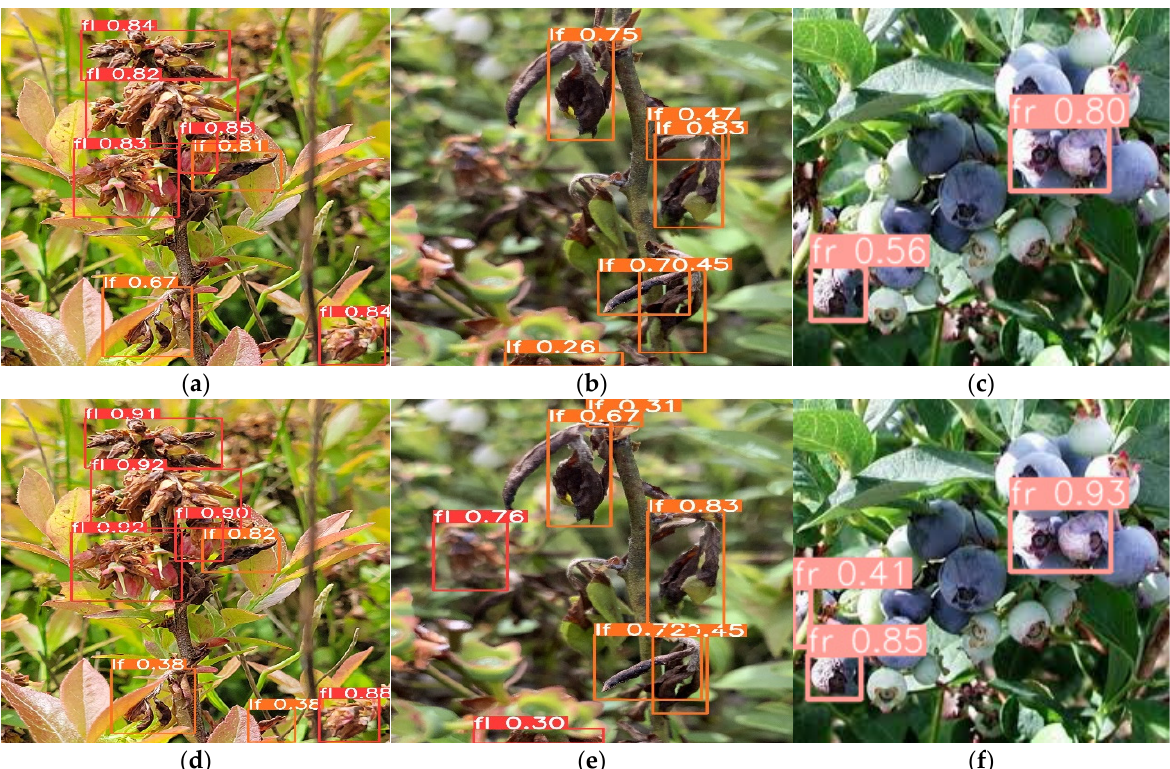
Figure 7. Comparison of detection results focused on the plant part. Yolov5s ( a – c ) and Yolov5s-CA ( d – f ).